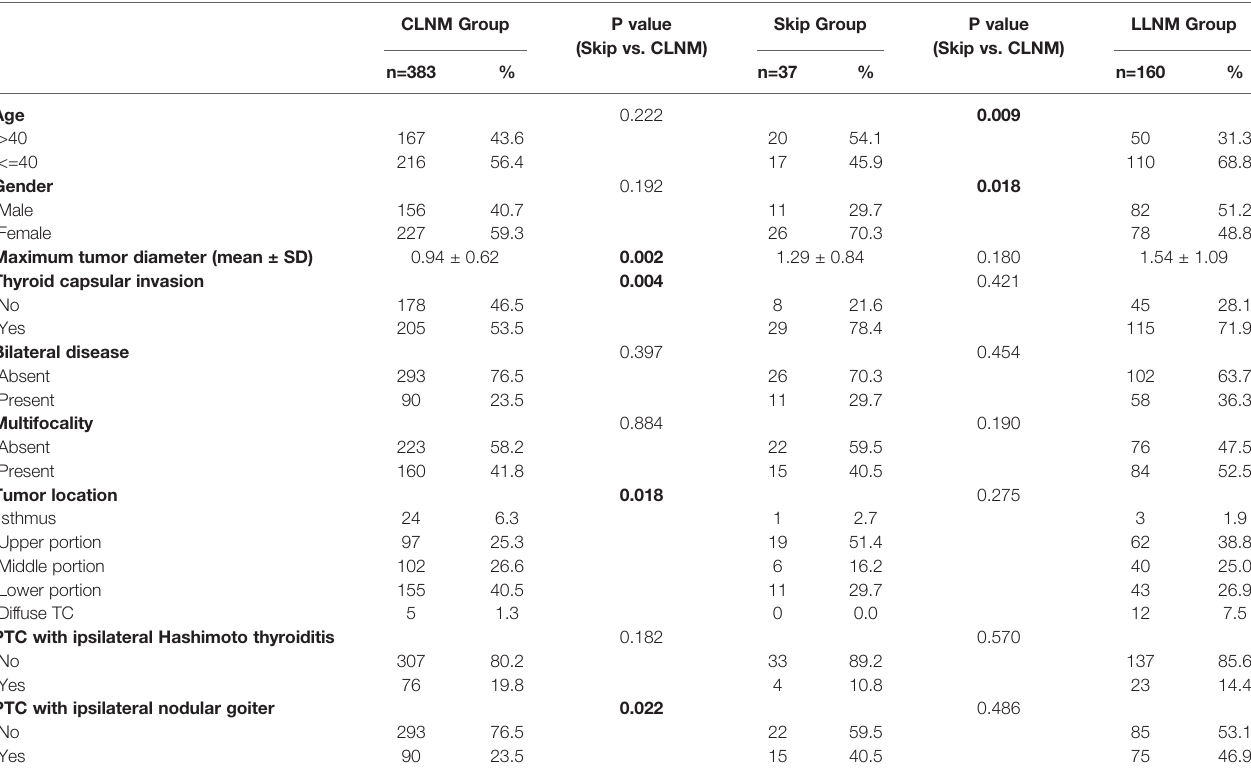
TABLE 2 | The clinicopathological characteristics of PTC patients with LNM.